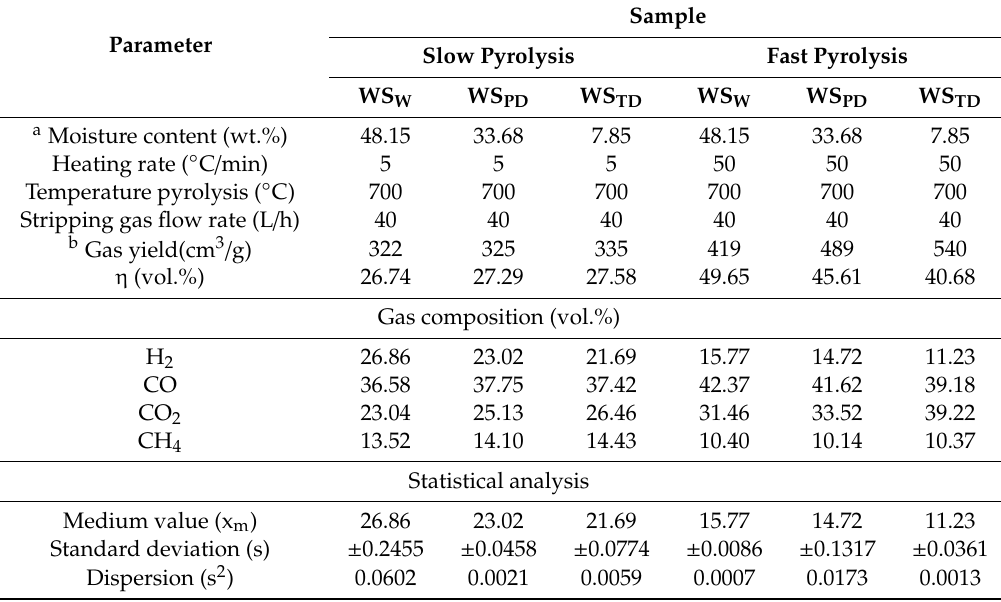
Table 2. The influence of the moisture content on the gas yield, conversion e ffi ciency ( η ) and gas composition (40 L / h striping gas flow rate) and statistical processing of experimental data obtained for the hydrogen content in the gas fraction, depending on the moisture content of the walnut shells